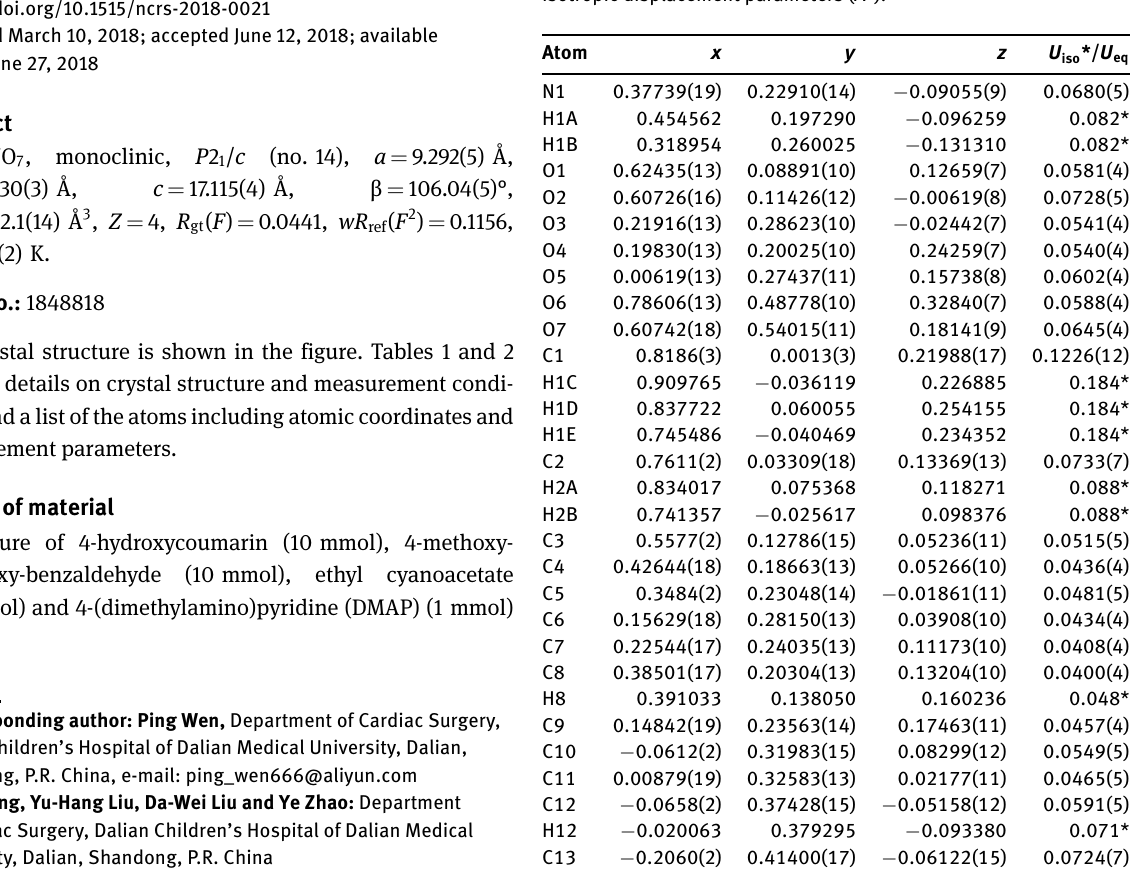
Table 2: Fractional atomic coordinates and isotropic or equivalent isotropic displacement parameters (Å 2